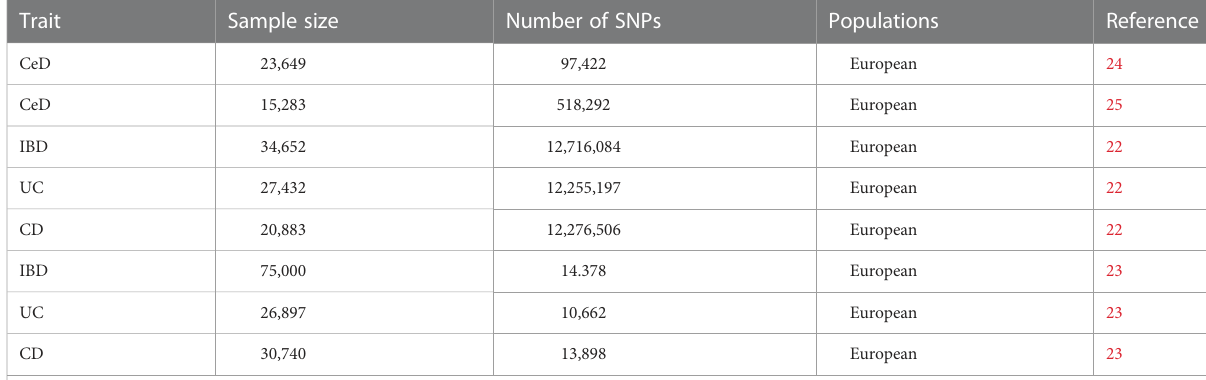
TABLE 1 Description of GWAS summary samples used in this